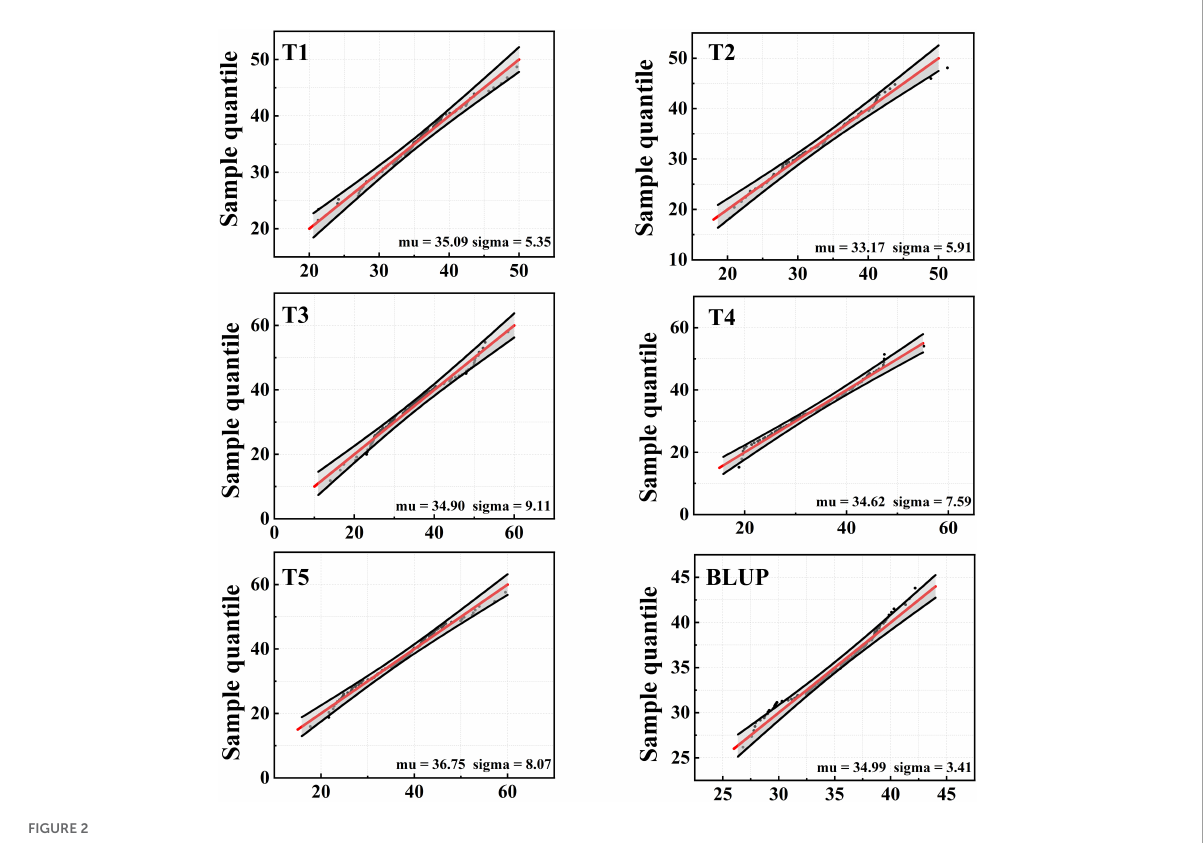
FIGURE2 Frequency distribution of maximum root length (MRL) for five tests and with BLUP dataset.